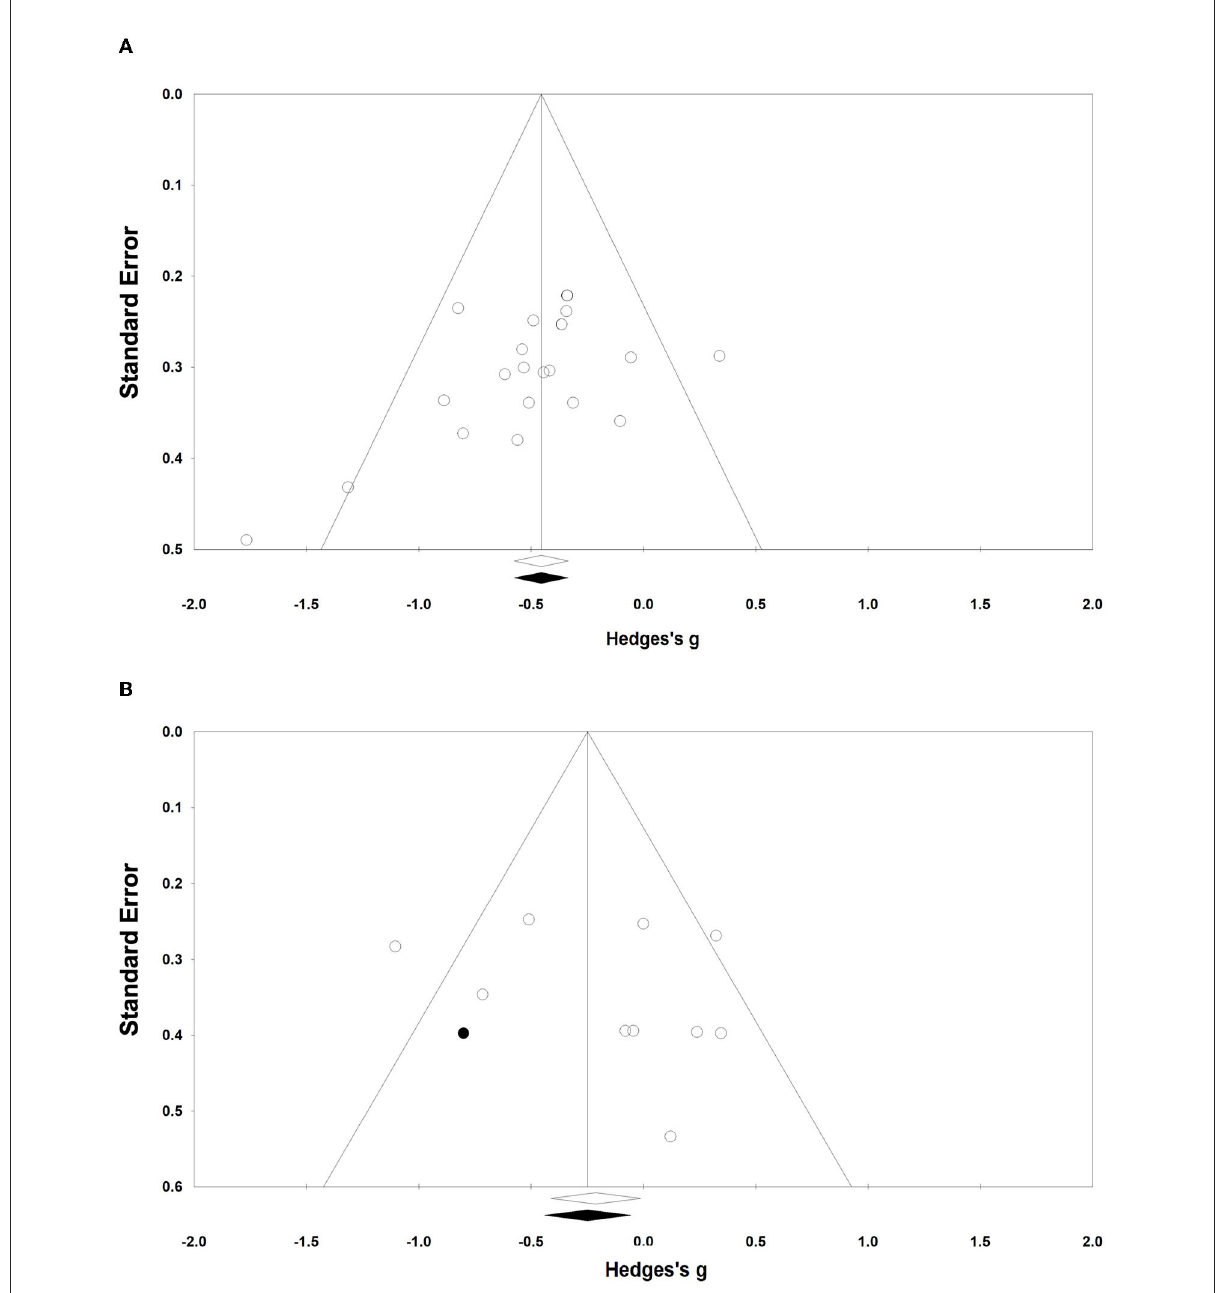
FIGURE3 Funnel plots of publication bias. (A, B) Funnel plots (A, B) represent the publication bias of the N-RCT and the RCT,